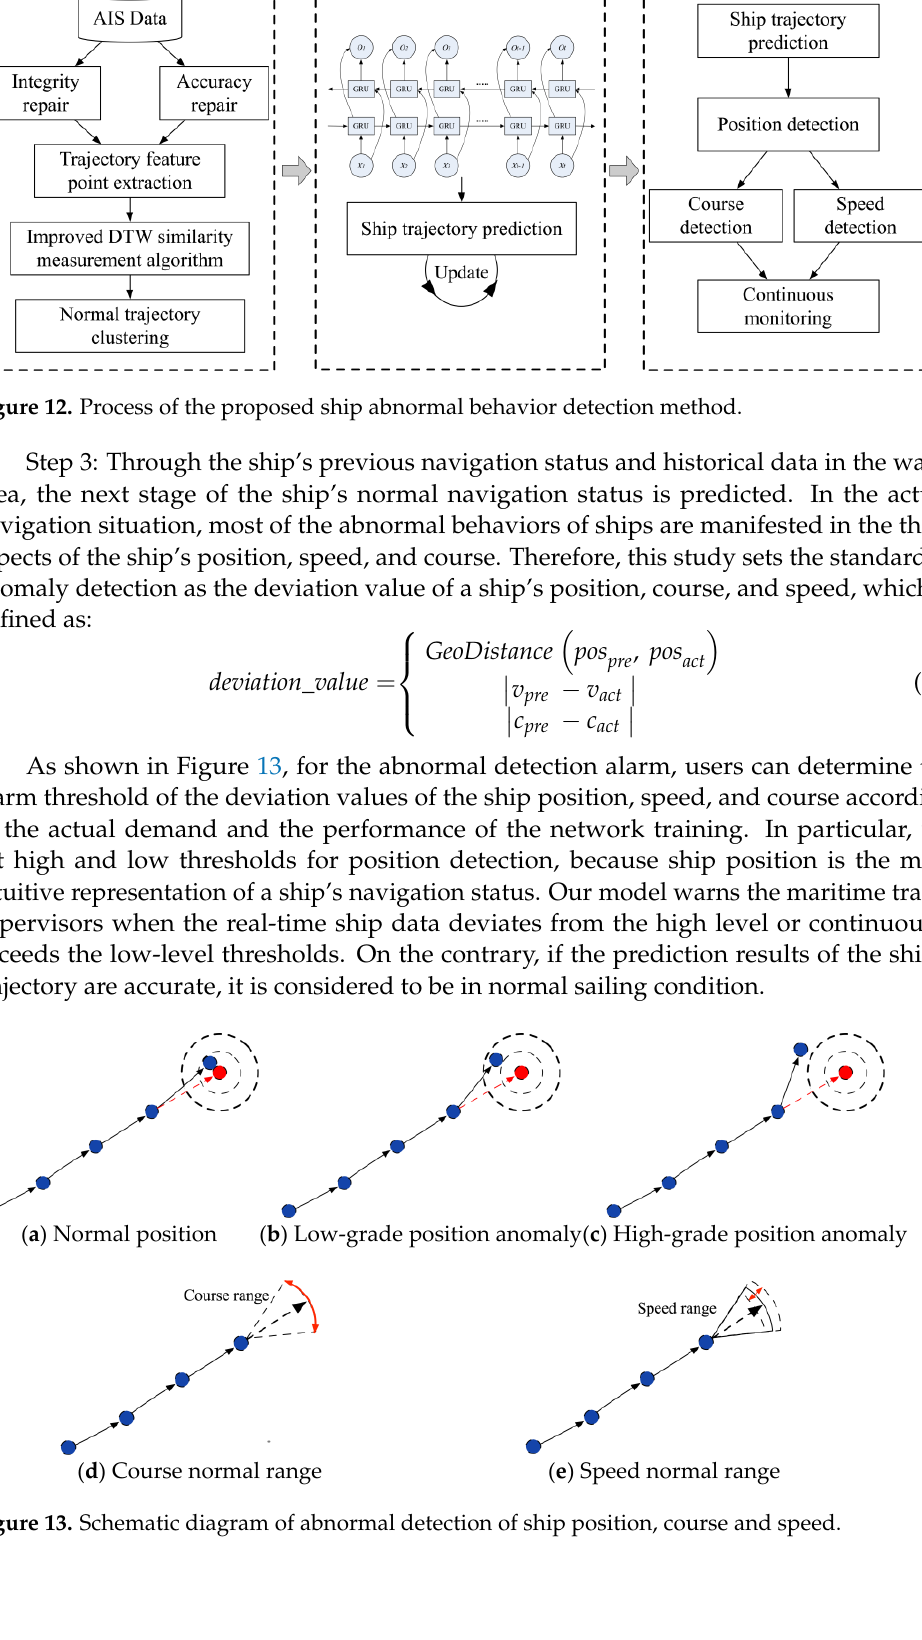
Figure 13. Schematic diagram of abnormal detection of ship position, course and speed.